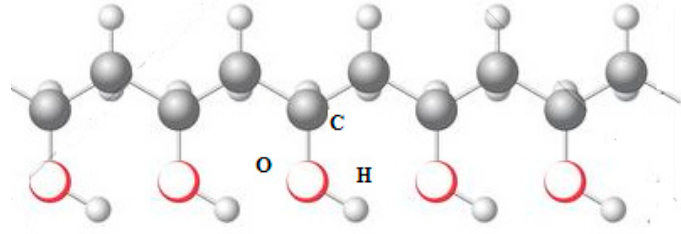
Figure 1. Polyvinyl alcohol (PVA) structure.